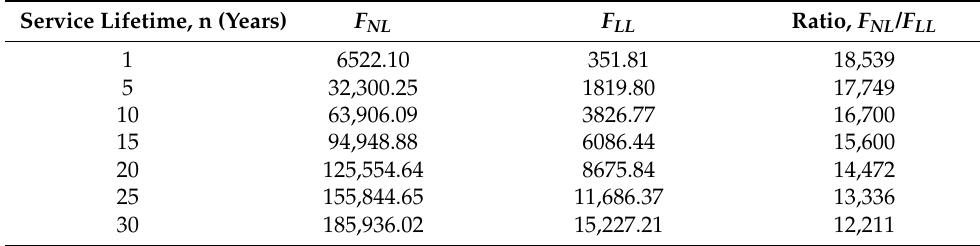
Table 3. Capitalisation of losses: proposed method (Equations (9) and (10)).